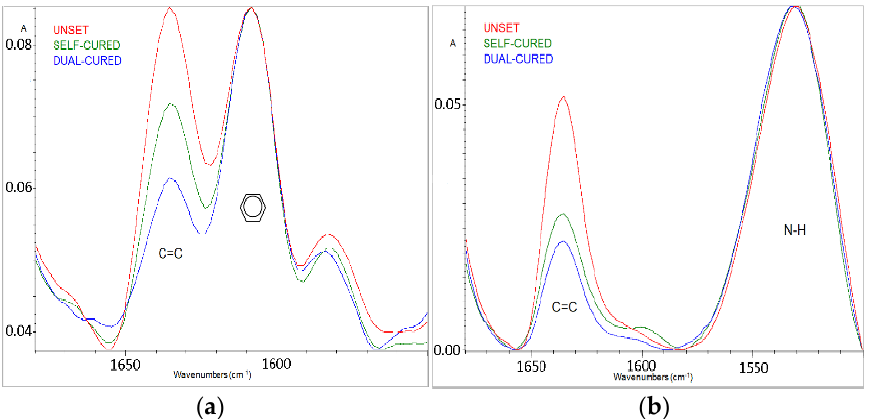
Figure 5. Expanded ATR-FTIR spectra of aromatic ( a ) and aromatic-free ( b ) materials before and after setting under the two curing modes, with the corresponding peak assignments used for DC% measurements ( y -axis:Absorbance units-A; x -axis: Wavenumbers-cm − 1 ). Table 4. The results of DC% for the products tested in dual-curing (DC) and self-curing (SC) modes *. Product